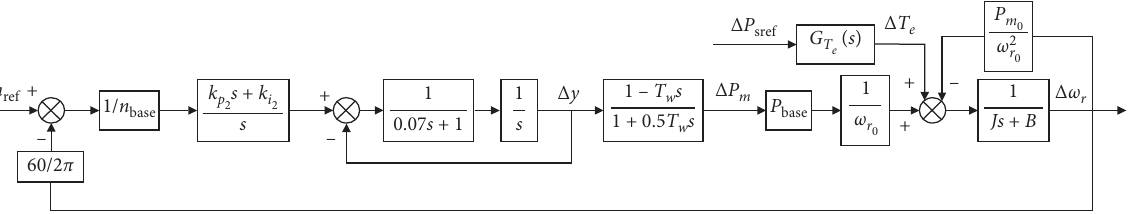
Figure 14: Linearized block diagram of the speed control